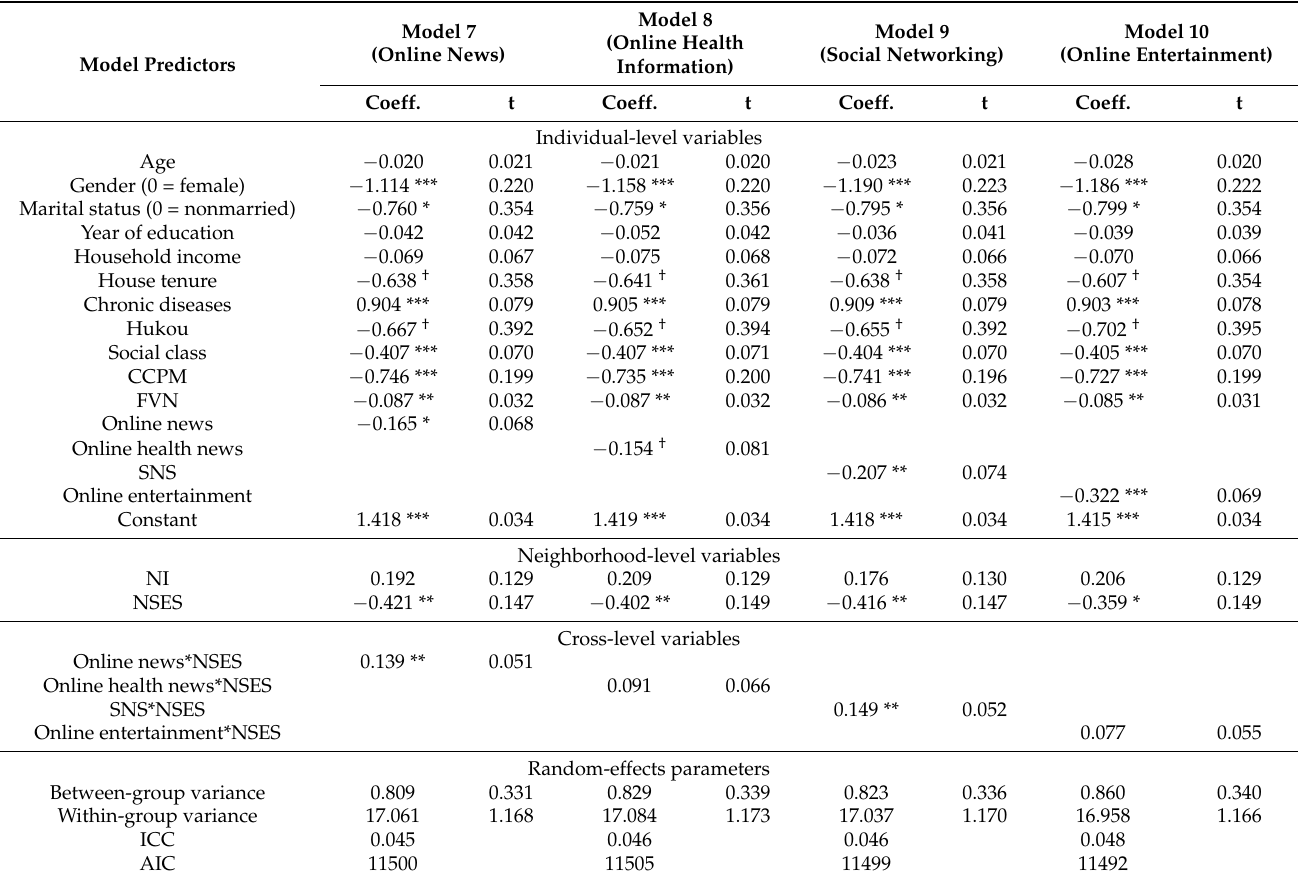
Table 4. The cross-level interaction models on mental distress, Neighborhood Socio-Economic Status (NSES), and four items of Internet